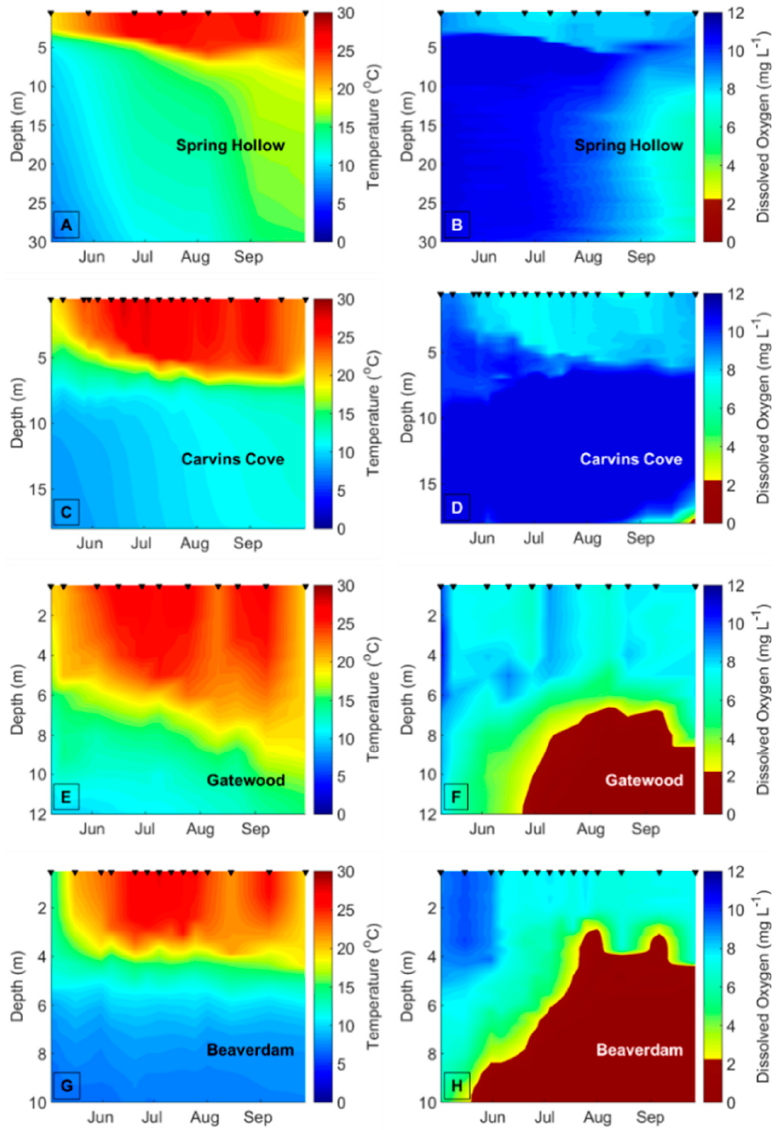
Figure 1. Temperature and dissolved oxygen (DO) depth profiles of the four focal reservoirs during the summer stratified period in 2014; the temperature and dissolved oxygen data for 2015 and 2016 are in Figures A1 and A2. The color scale for the dissolved oxygen concentrations highlights the hypoxia threshold at 2 mg L − 1 . The hypolimnia of the Spring Hollow Reservoir (SHR) ( A , B ) and Carvins Cove Reservoir (CCR) ( C , D ) remained oxic throughout the summer; while the hypolimnia of Gatewood Reservoir (GWR) ( E , F ) and the Beaverdam Reservoir (BVR) ( G , H ) developed hypoxia towards the end of June and early July. Carvins Cove does sometimes develop hypolimnetic hypoxia towards the end of the summer stratified season, but this is limited to the bottom meter. Black triangles on the top of each panel represent sampling days, and the intervening data were